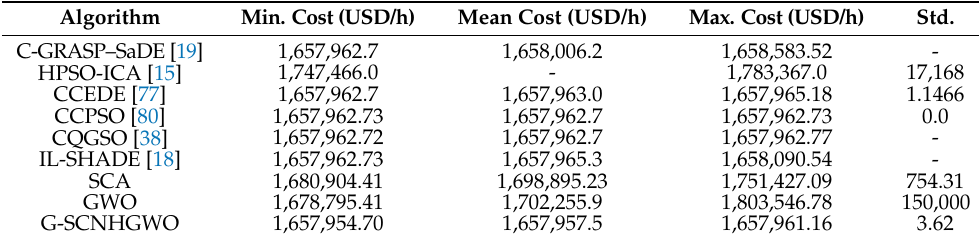
Table 12. Comparison of best results obtained by different algorithms for Case D.